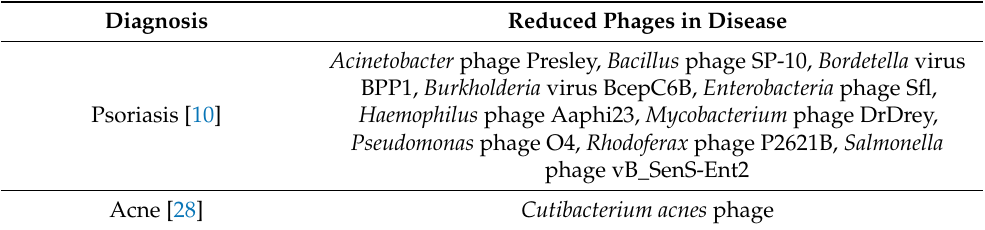
Table 1. Relative reduction in phages associated with dermatologic